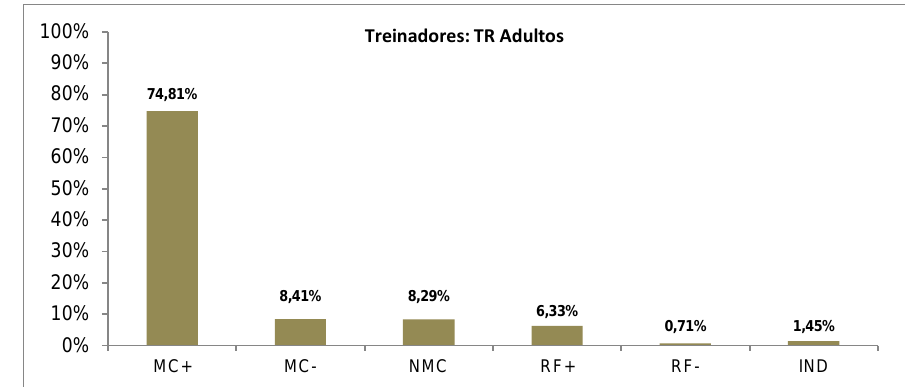
Figura 8. Valores em porcentagem da dimensão comportamento motor reativo durante a competição(MC+ - Modifica Comportamento Positivamente; MC- - Modifica o Comportamento Negativamente; NMC – Não Modifica o Comportamento; RF+ - Reforço Positivo; RF- - Reforço Negativo, IND –